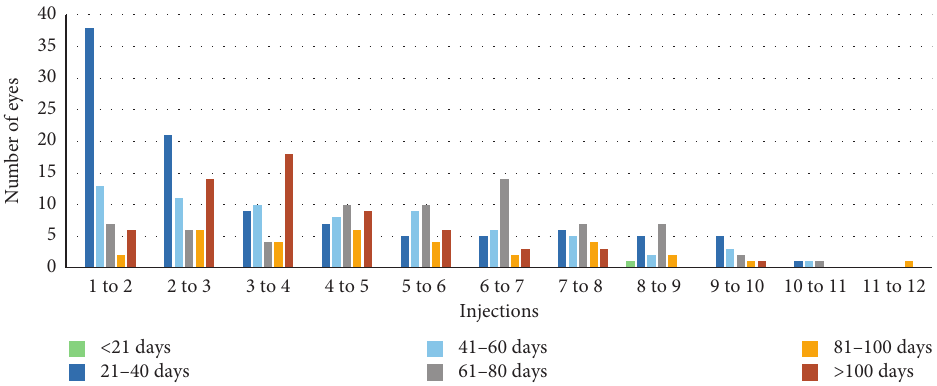
Figure 1: Intervals between